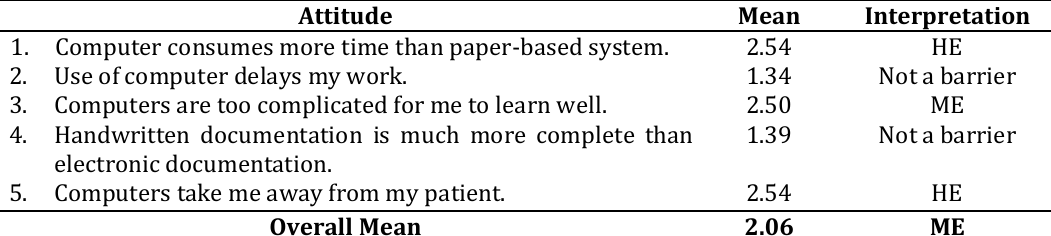
Barriers faced by nurses in using Electronic Health Records measured along attitude on EHR Attitude Mean